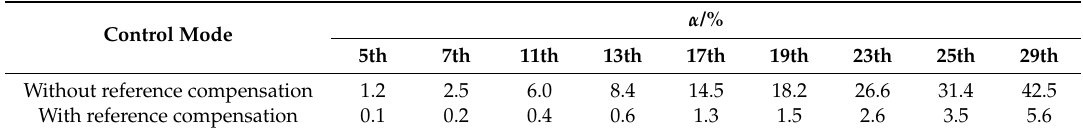
Table 3. Error of the harmonic current compensation.